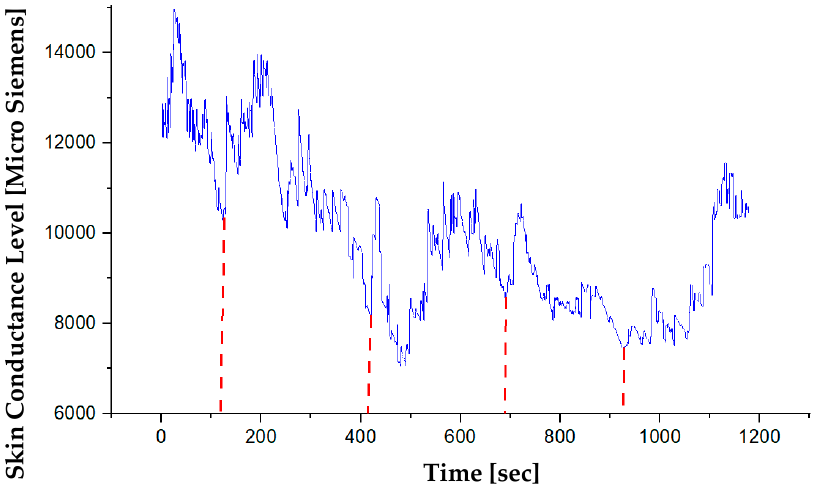
Figure 15. Skin Conductance Level of a pilot during the scenario.